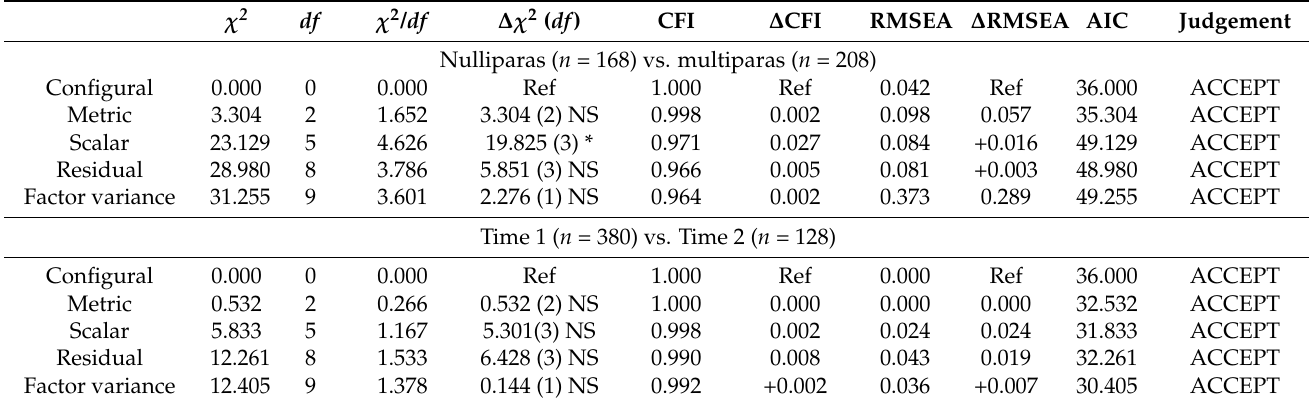
Table 2. Measurement and structural invariance of the SDS.